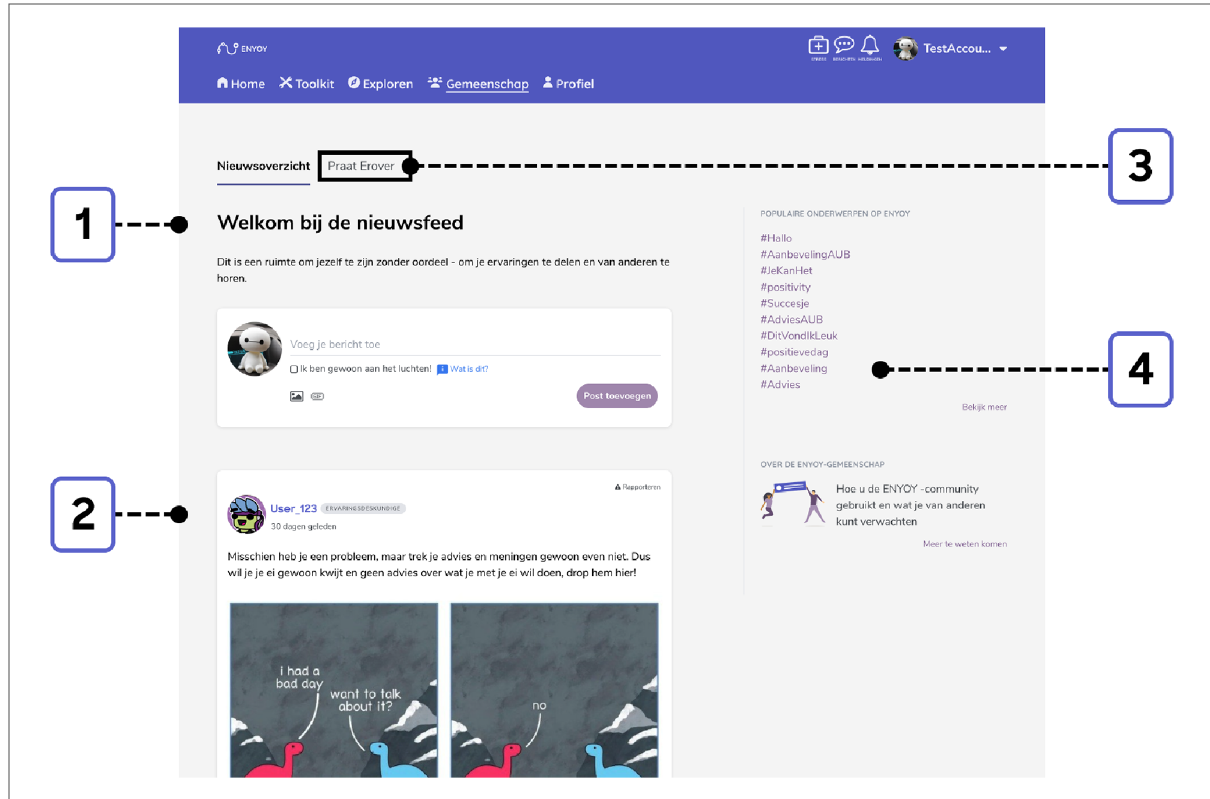
FIGURE 3 Exemplary community. 1=Newsfeed and option to add a message to the